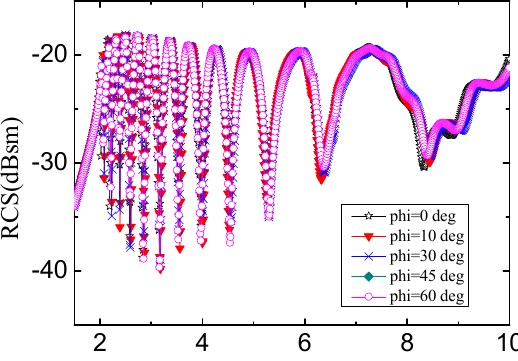
Figure 9. The spectrum of altering θ from 0° to 60° when φ = 0°. The substrate is F4BM.